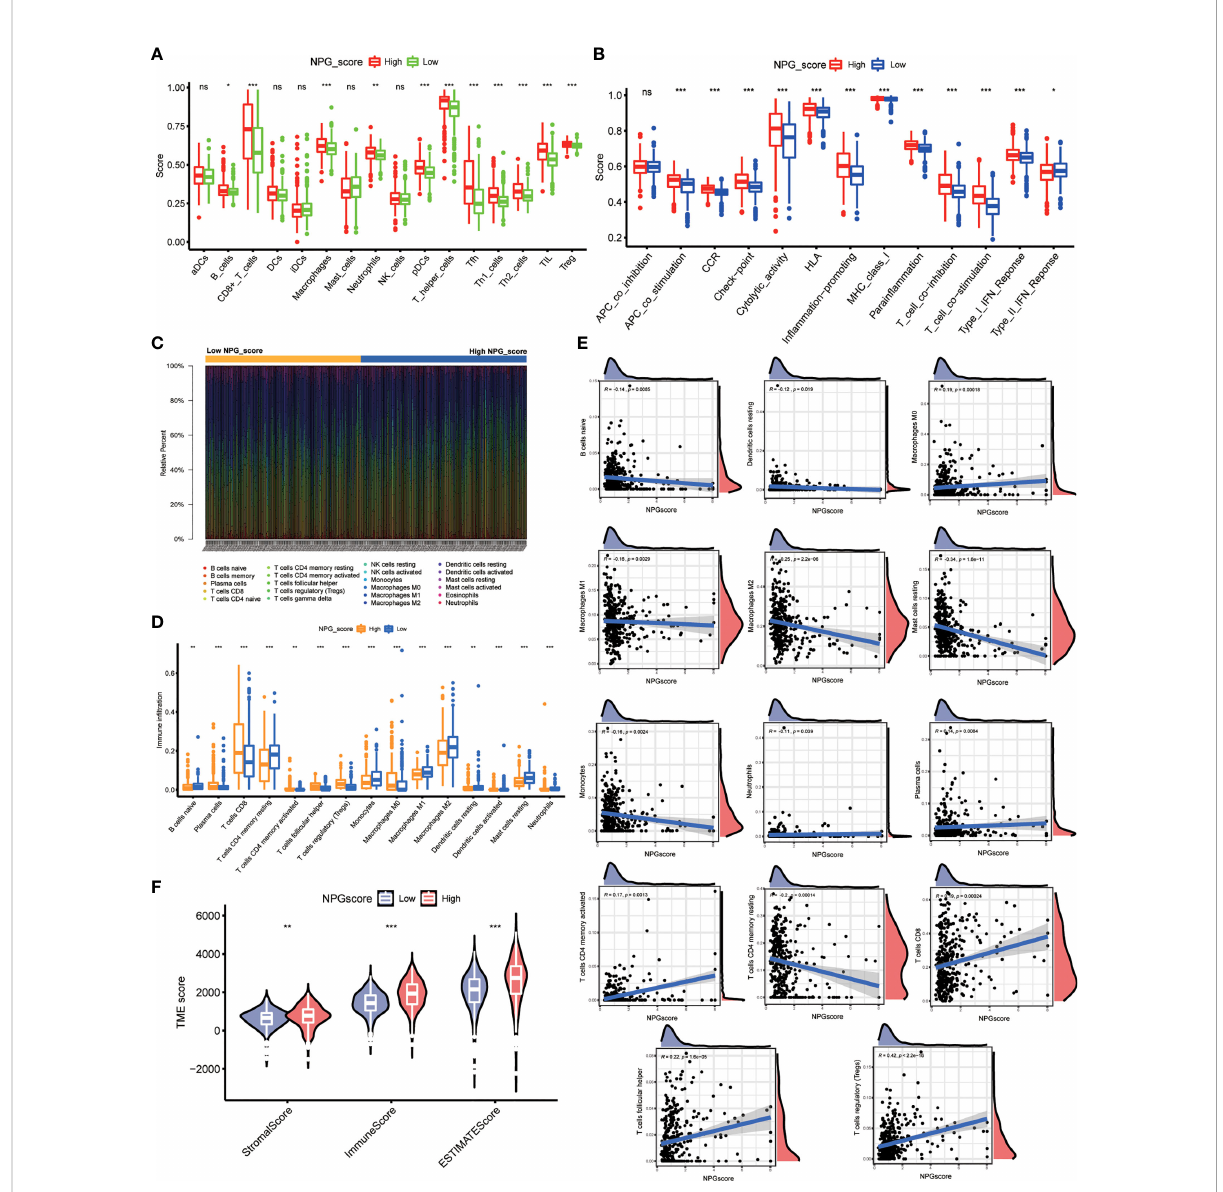
FIGURE 7 Correlation of NPG score with TME cell in fi ltration. (A) ssGSEA analysis of NPG score and immune in fi ltration levels in ccRCC. (B) Comparison of immune-related functions scores in low- and high- NPG score groups. (C, D) Difference in immune cell in fi ltration levels evaluated by CIBERSORT in ccRCC. (E) The relationship of NPG score and different immune cell in fi ltration levels. (F) Correlation analysis between TME scores and NPG score in ccRCC *P < 0.05; ** P < 0.01; *** P< 0.001; ns, no signi fi